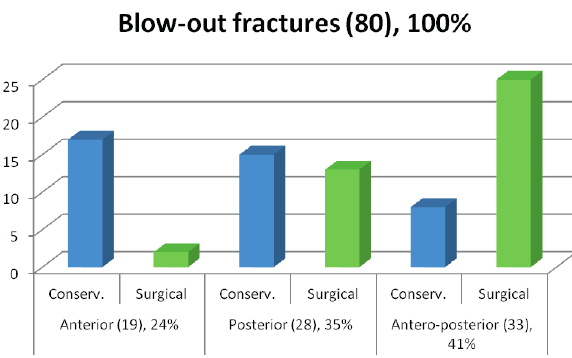
Fig. 4. Relationship between conservative and surgical therapy and fracture